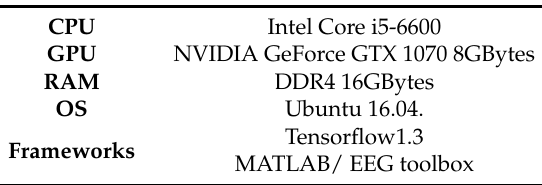
Table 3. Hardware Table 3. Hardware specifications.